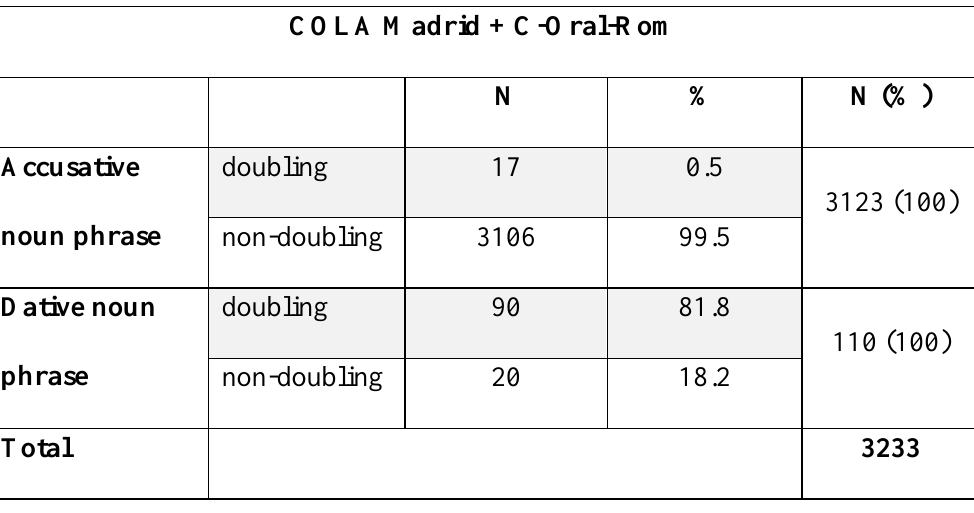
Table 2. Proportion of doubling of accusative and dative noun phrases in COLA Madrid + C- Oral ROM (Rinke et al. 2019: 28)